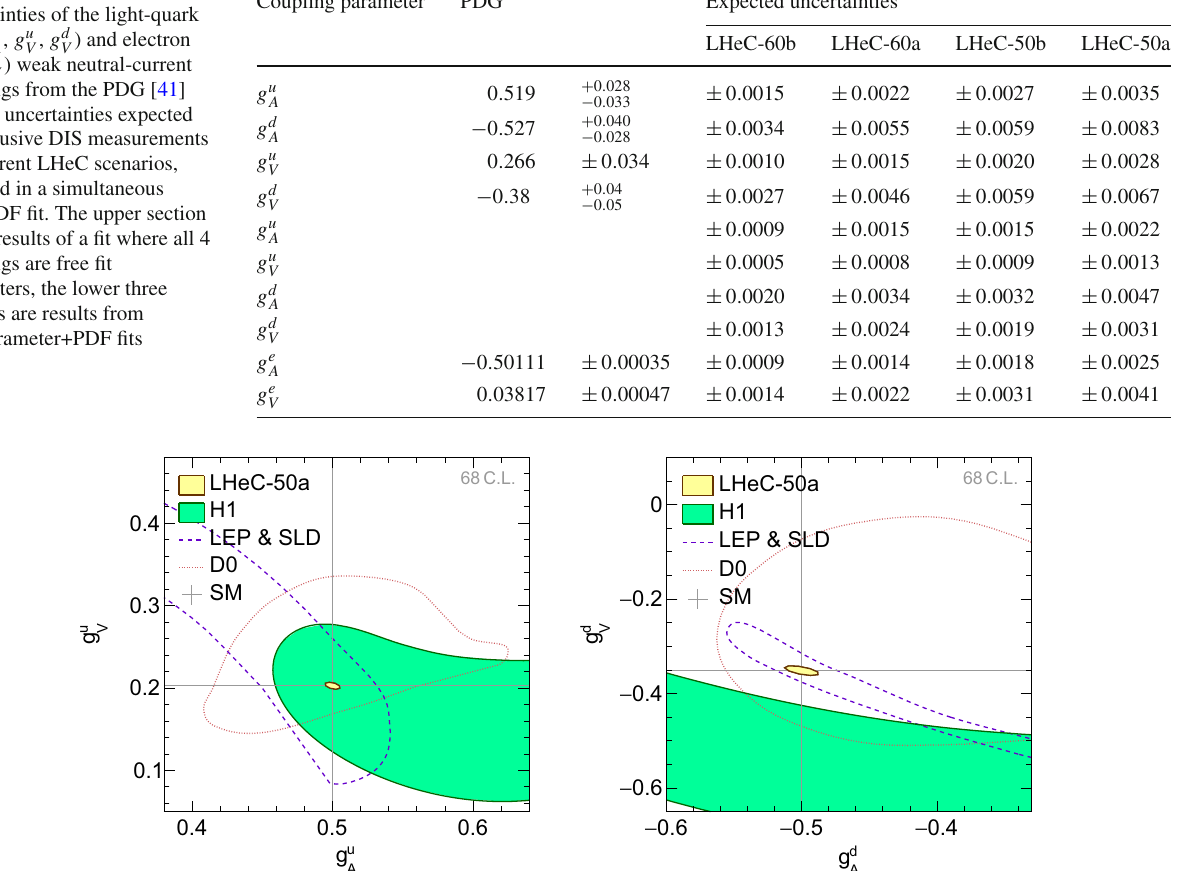
Fig. 16 Weak-neutral-current vector and axial-vector couplings of up- type quarks to the Z -boson (left), and those of the down-type quarks (right) at 68% confidence level for simulated LHeC data with E e = 50GeV (scenario LHeC-50a). The LHeC expectations are compared